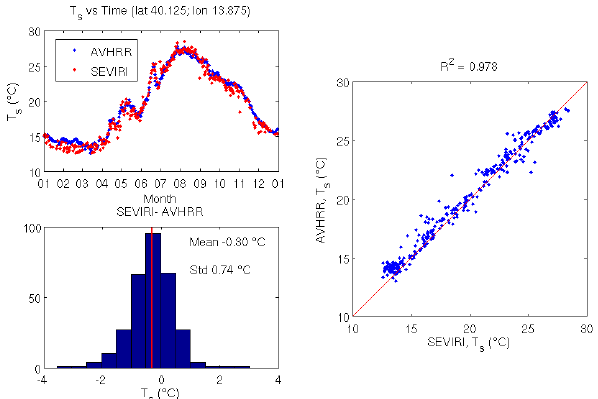
Figure 16. Year 2013. Comparison of daily values of T s derived from SEVIRI and AVHRR. Clockwise from top left, time series of daily mean of T s , scatter plot, and histogram of the SEVIRI– AVHRR